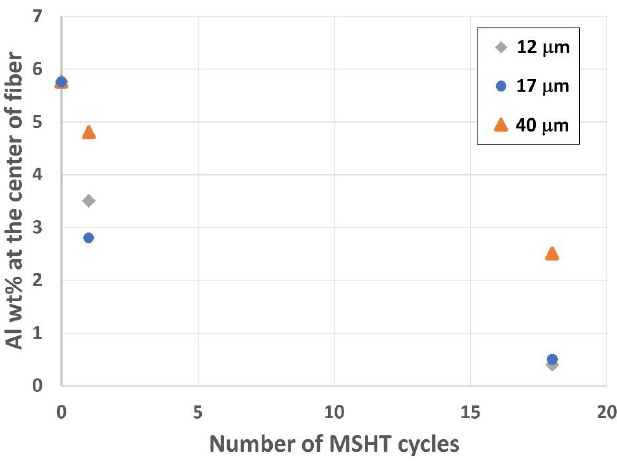
Figure 19. Aluminum concentration, in wt.%, at the center of the 12, 17, and 40 μm FeCrAl fibers versus the number of MSHT cycles. versus the number of MSHT